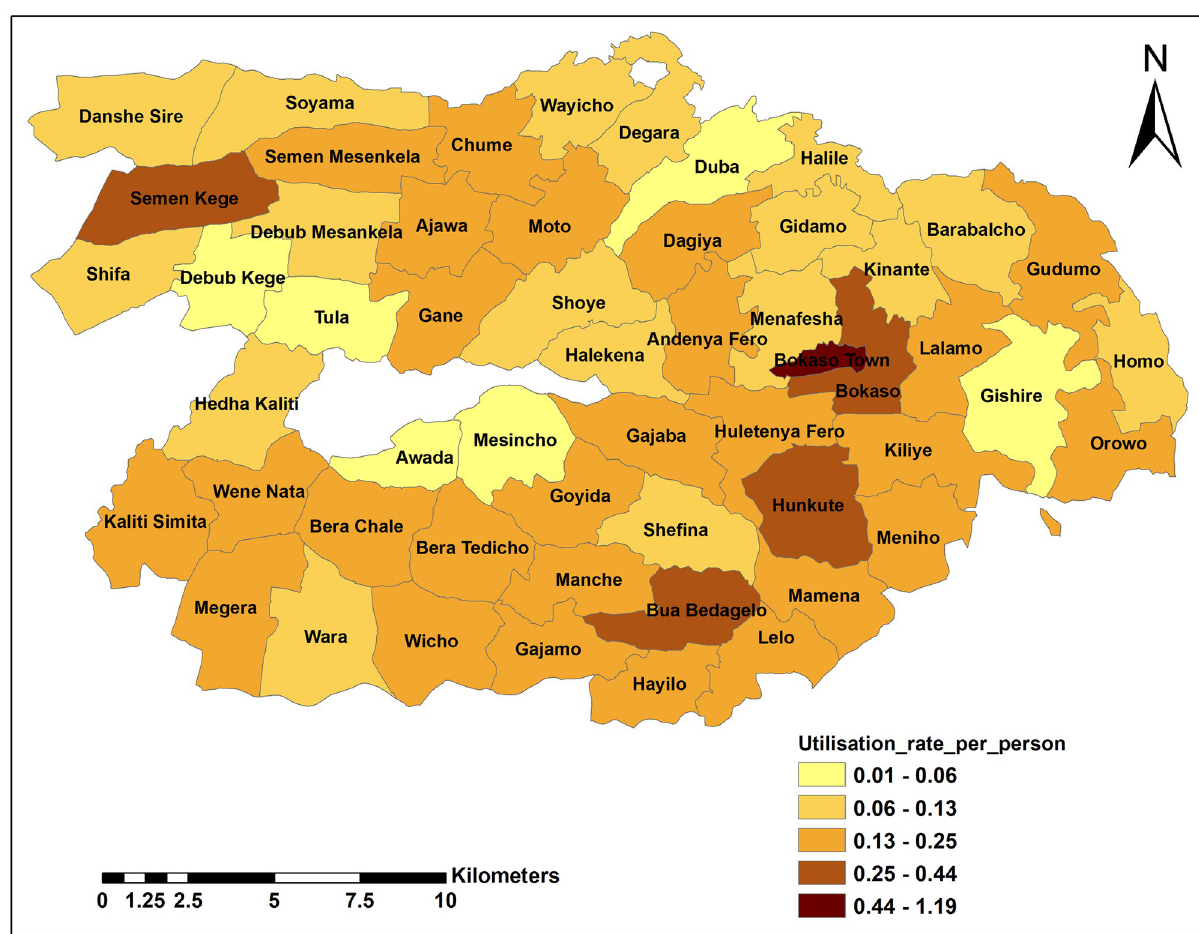
Fig 2. Spatial distribution of annual health service utilisation rate by kebeles in Dale and Wonsho districts, Sidama, southern Ethiopia, 2017/18 (Unit: Rate per person per year).